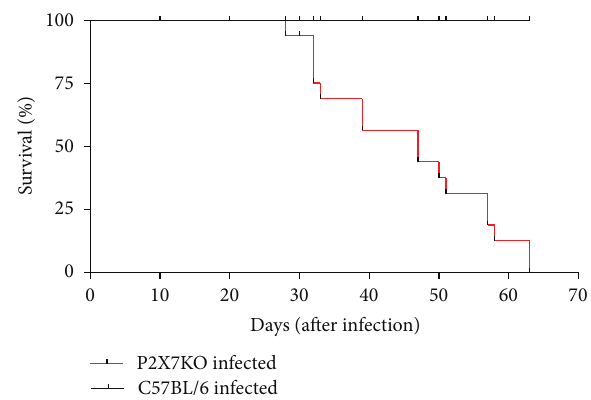
Figure 7: Survival curve of C57BL/6 wild type or P2X7 KO infected with approximately 80 cercariae of S. mansoni . (P2X7 KO: 𝑛 = 9 females and 7 males; C57BL/6 wild type: 4 females and 10 males). ∗∗∗ 𝑃 < 0.0001 using the Mantel-Cox log-rank test.